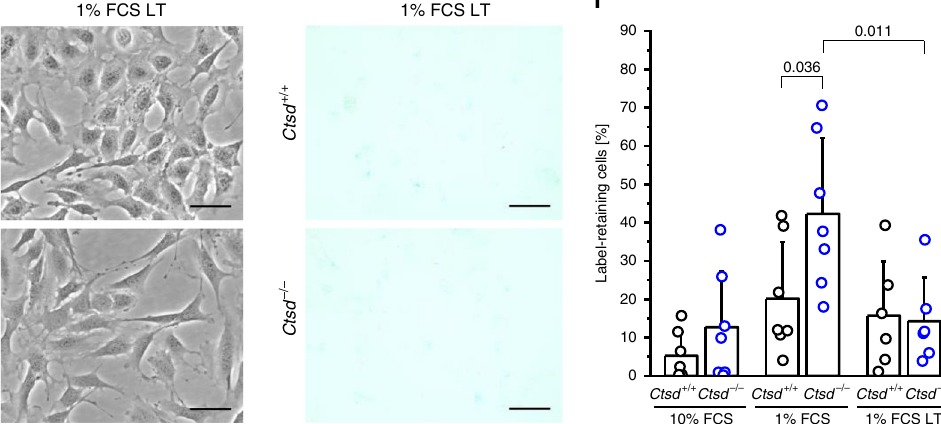
Fig. 7 CTSD-de fi cient tumors overcome the initial growth arrest independent of somatic mutations. a Time from fi rst palpation to end-stage for tumors of PyMT mice of indicated genotypes ( n = 12 animals for controls (4× Ctsd + / fl + 8× Ctsd fl / fl ), n = 10 animals for MMTV-cre;Ctsd − / − ). b Metastatic burden in lungs from PyMT mice of indicated genotypes with end-stage tumors ( n = 12 animals for controls (4× Ctsd + / fl + 8× Ctsd fl / fl ), n = 10 animals for MMTV- cre;Ctsd − / − ). c Proportion of different types of somatic and loss of heterozygosity (LOH) mutations detected by whole exome sequencing in tumors from 18-week-old PyMT mice of indicated genotypes (Controls: Ctsd fl / fl ; n = 4 animals). d Circos plots showing mutations from c along the chromosomes per individual control (left) and MMTV-cre;Ctsd − / − (right) tumor (represented as separate concentric rings). Deletion of Ctsd exon 2 is highlighted in red. Continuous gray lines mark positions of homologs of frequently mutated genes in human breast cancer. e Pictures of unstained (left) and acidic β - galactosidase-stained (right) Ctsd + / + (top) and Ctsd − / − (bottom) PyMT cells cultured for ≥ 8 weeks in 1% FCS medium (1% FCS LT). Compare to Fig. 3a, b for short-term 1% FCS Ctsd + / + and Ctsd − / − PyMT cells. Bars, 50 μ m. Representative of 2 independent experiments. f Quanti fi cation of label-retaining cells among 1% FCS LT Ctsd + / + and Ctsd − / − PyMT cells ( n = 6 independent experiments; two-sided two-sample t -test). Short-term conditions (10% FCS, 1% FCS) as presented in Fig. 3c are included for convenient comparison. Bar charts show all data points with mean + SD and p -value. Source data are provided as a Source Data fi